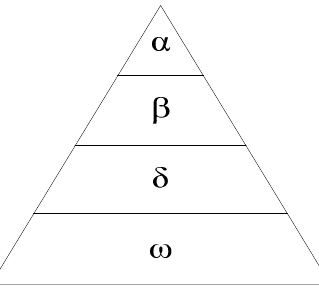
Figure 1. Grey wolf social hierarchy.